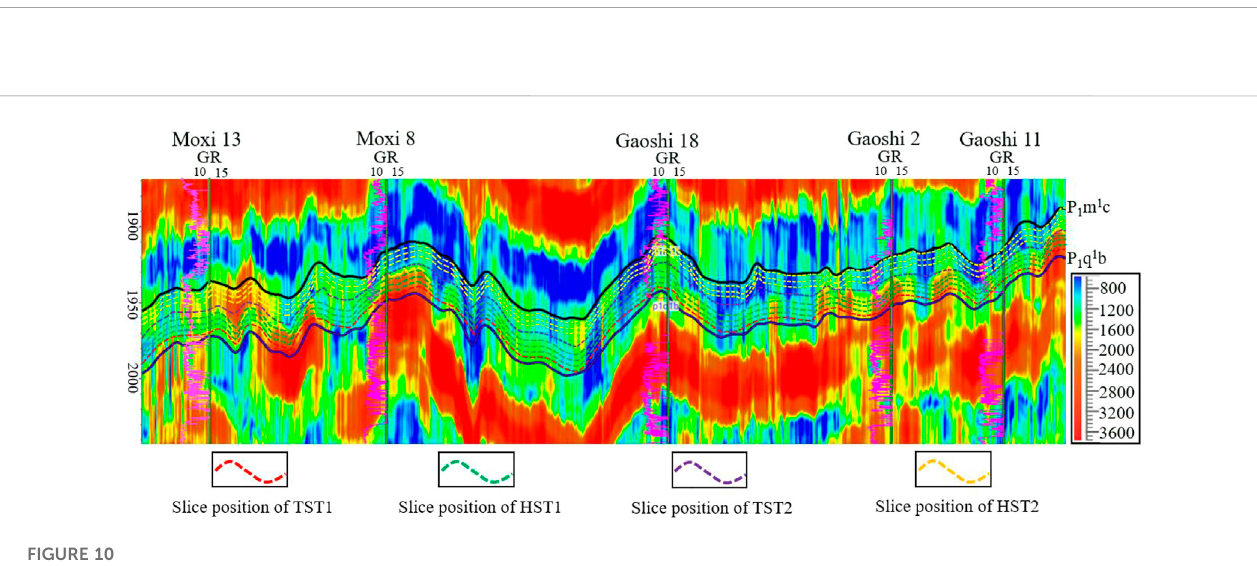
Root mean square amplitude attribute pro fi le and slice